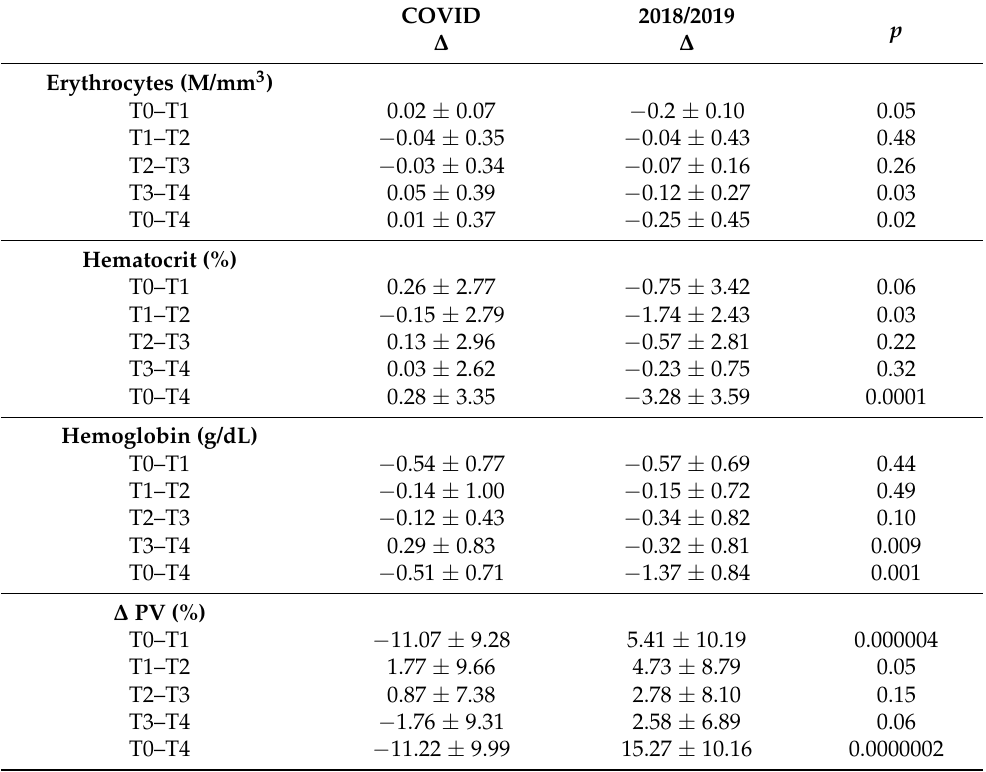
Table 3. Differences ( ∆ ) in red blood cells and hemoglobin concentration, hematocrit percent- age, and plasma volume between each timepoint in football players for 2018/2019 and 2019/2020. p -values < 0.05 obtained by t -test show statistical differences in ∆ values.